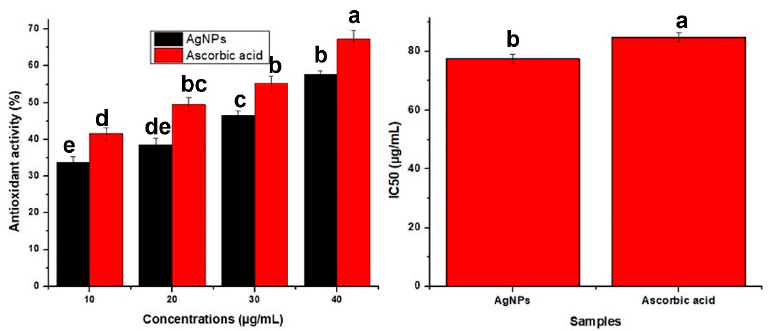
Figure 8. Antioxidant activity of AgNPs. All values are the average of 3 replicates, the error bar represents the standard errors of the means, and different letters indicate the significant difference at p = 0.05 by LSD test.